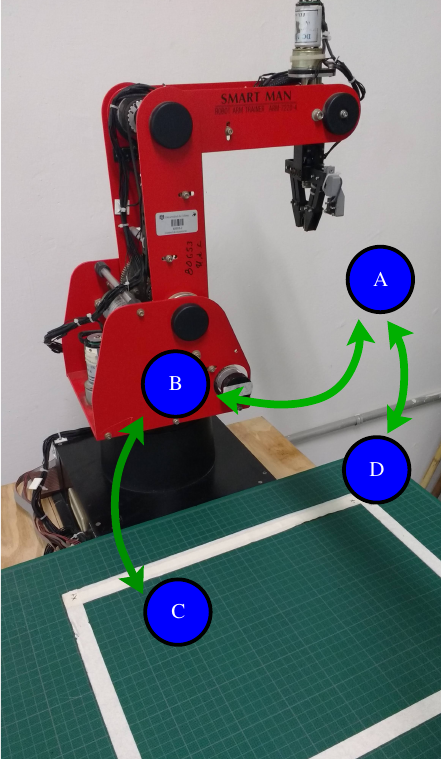
Figure 10. Sequence of Points A–D to move the